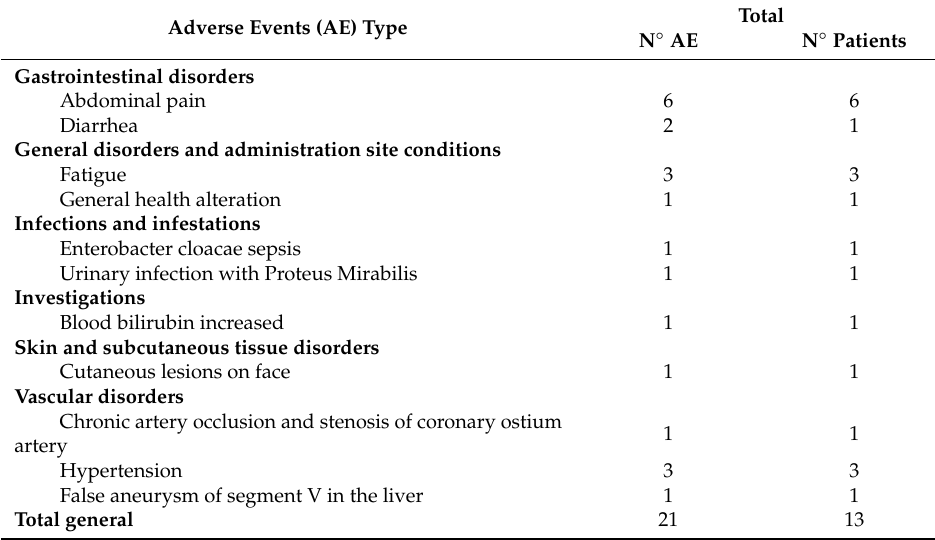
Table 3. Adverse events grade ≥ 3 related to LifePearl ®